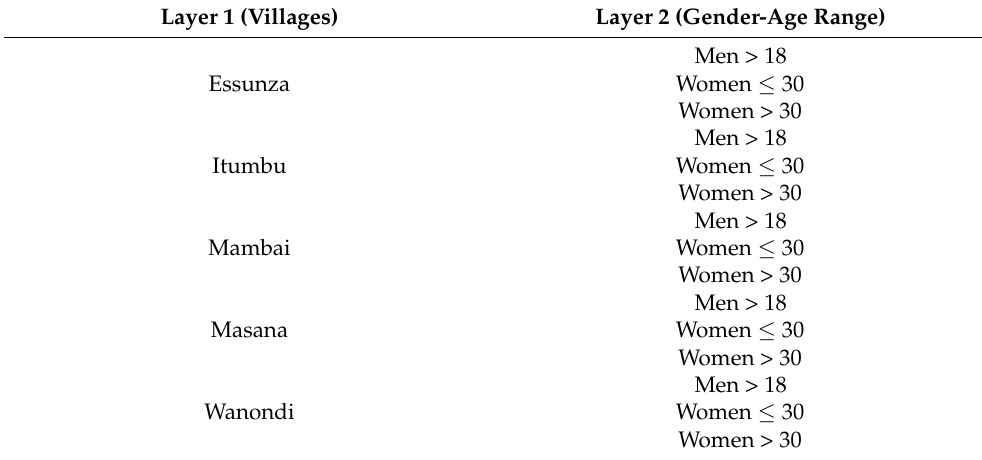
Table 1. Double-layer design for Focus Group Discussions (FGD) in Vihiga County,